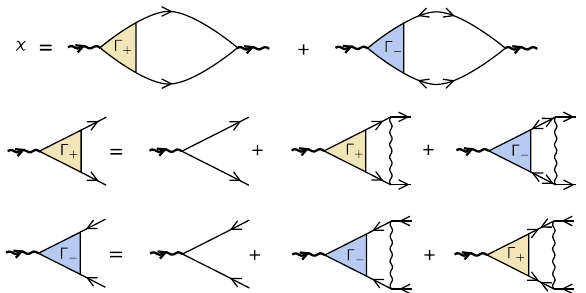
Fig. 7 Diagrammatic representation of χ . Straight lines with a single arrow represent normal fermion propagators G , lines with a double arrow anomalous propagators F . Thin wavy lines represent interactions V , thick wavy lines the pairing fi eld Δ